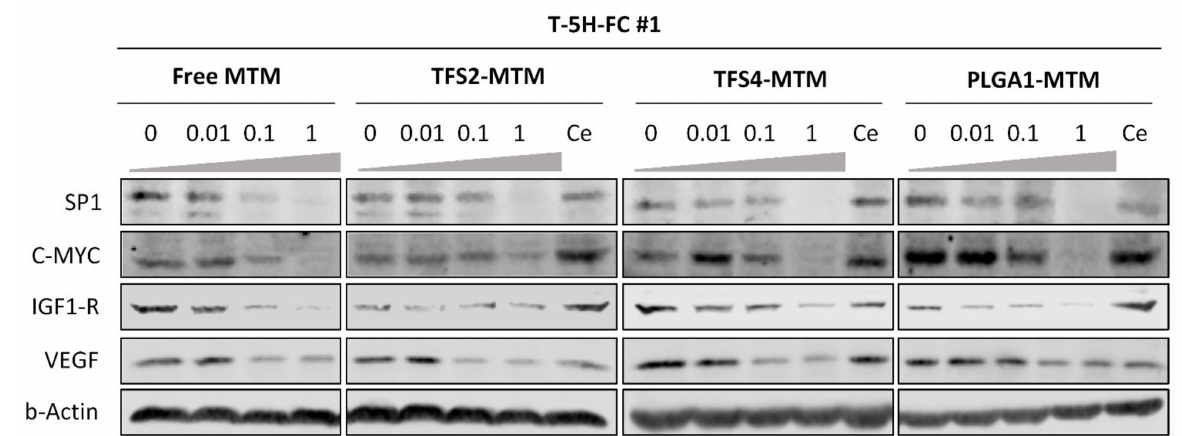
Figure 4. Inhibition of SP1 signaling by free and nano-encapsulated MTM. Western blotting analyses of SP1 and several SP1 downstream targets in T-5H-FC#1 cells treated with the indicated concentrations of the different MTM formulations for 24 h. A treatment with empty nanoparticles (Ce) at a concentration equivalent to the higher encapsulated MTM dosage was also included. The expression of β -actin was used as the loading